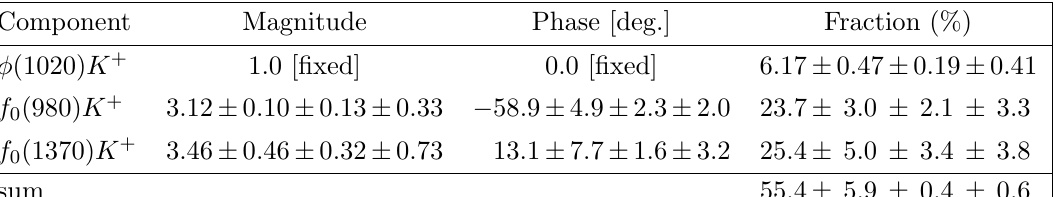
Table 2 . Fit results with model A, given in terms of the magnitudes j c k j , phases, arg( c k ) (in degrees), and (cid:12)t fractions (in %). For each measurement, the (cid:12)rst uncertainty is statistical, the second systematic and the third is a systematic uncertainty due to model.